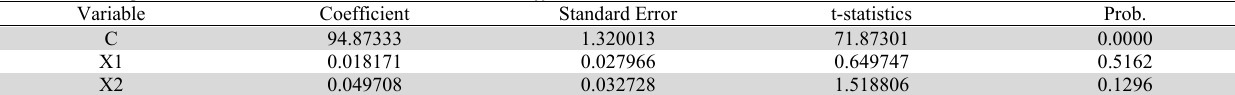
Panel . Data Regression . Test Results . with . the Random Effect